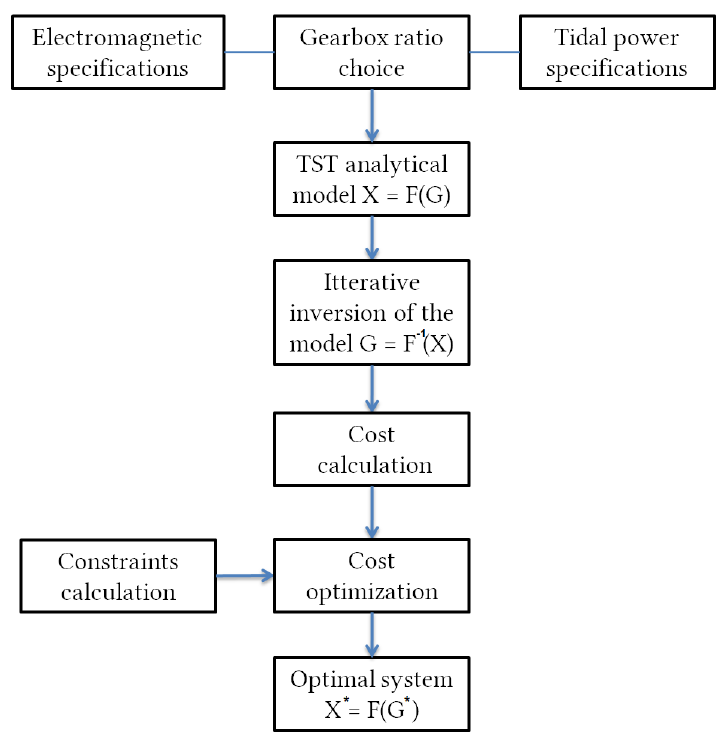
Figure 12. Flowchart describing the design optimization